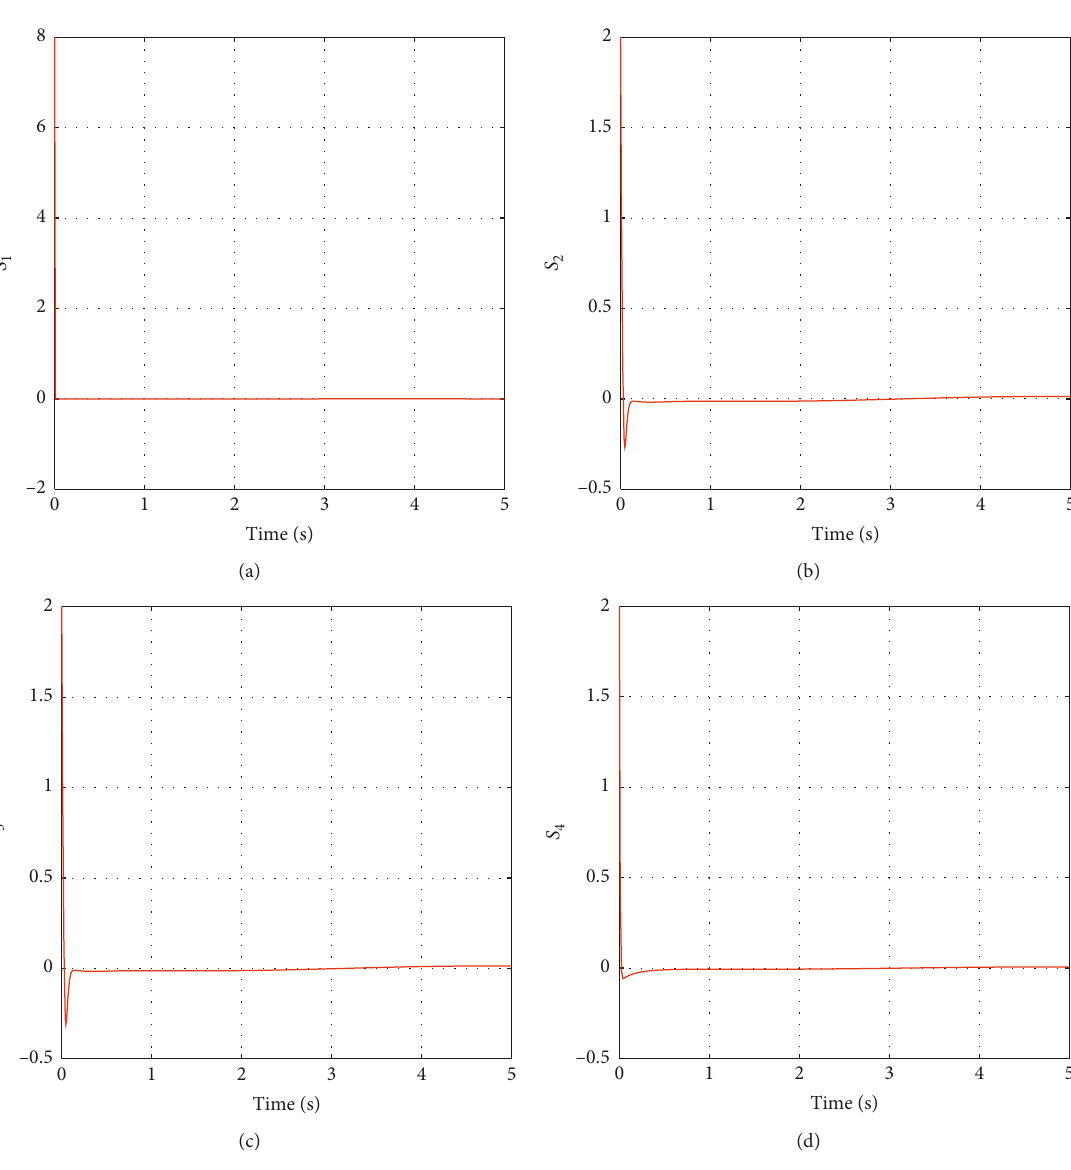
Figure 3: The time histories of the sliding